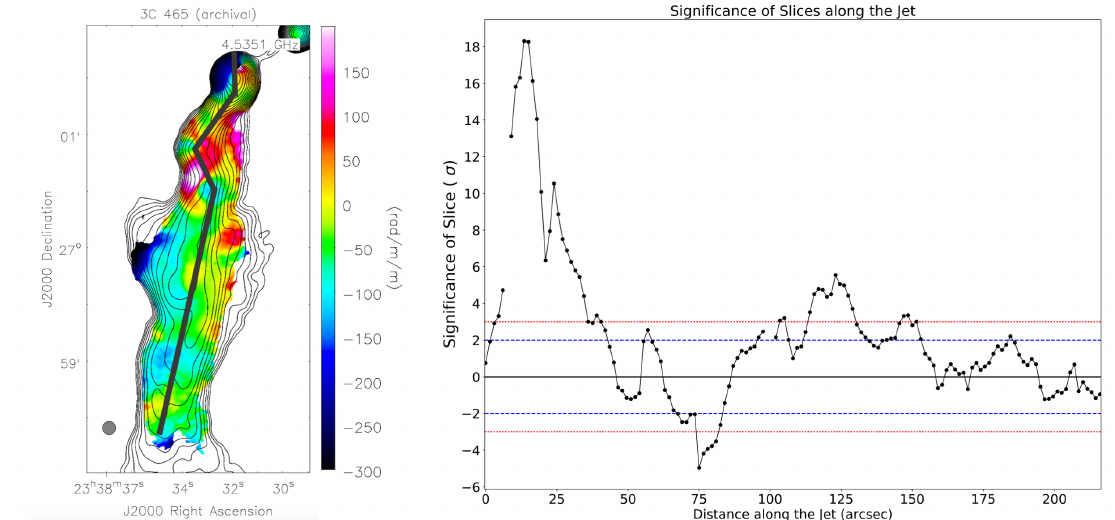
Figure 3. Left panel shows a Faraday rotation measure image of the southern jet of 3C 465 made using archival VLA observations at 4.5–5 GHz and 8–8.9 GHz. The contours show the total intensity √ at 4.534 GHz starting at 0.3 mJy and increasing by factors of 2. The beam is shown by the circle in the bottom left hand corner of the left panel. Right panel shows the significance of transverse RM gradients along the jet, starting at the northern end of the hotspot. The estimated jet direction is given by the thick, dark-grey line superposed on the RM image in the left panel. The significance of the RM gradients is measured every 1.5 (cid:48)(cid:48) along the jet. The levels of ± 2 σ and ± 3 σ are given as blue and red dashed lines